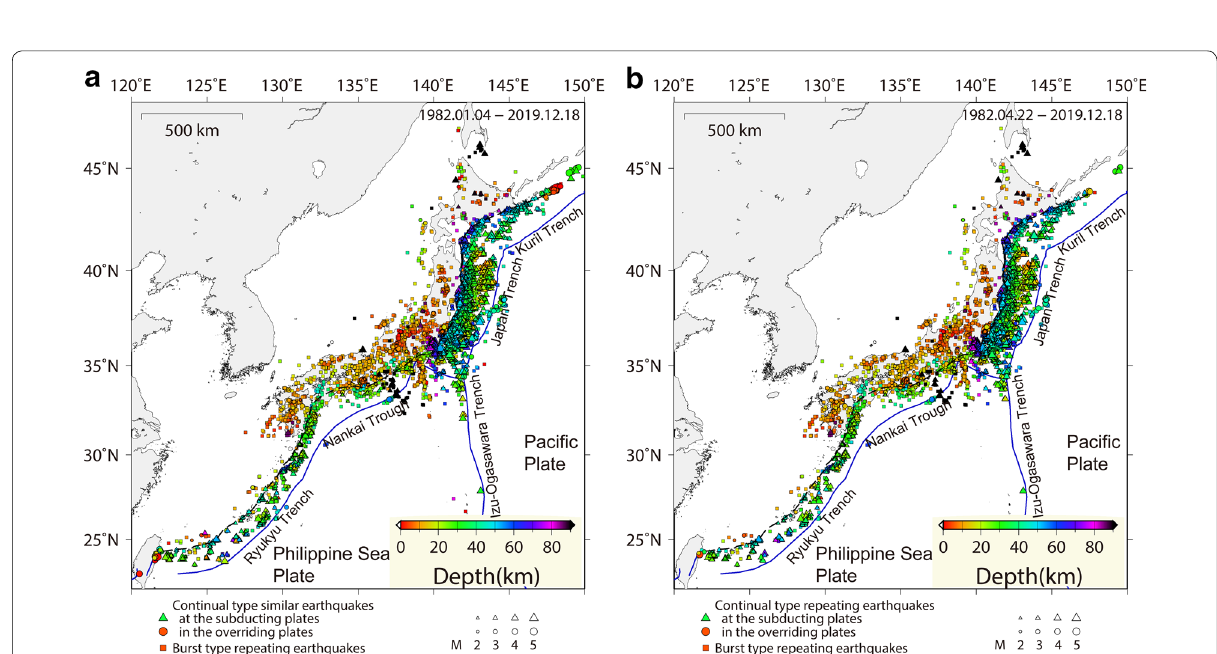
Fig. 3 Spatial distributions of a similar earthquakes and b small repeating earthquakes in Japan. Dashed lines indicate the downdip limit of interplate coupling (Igarashi et al.